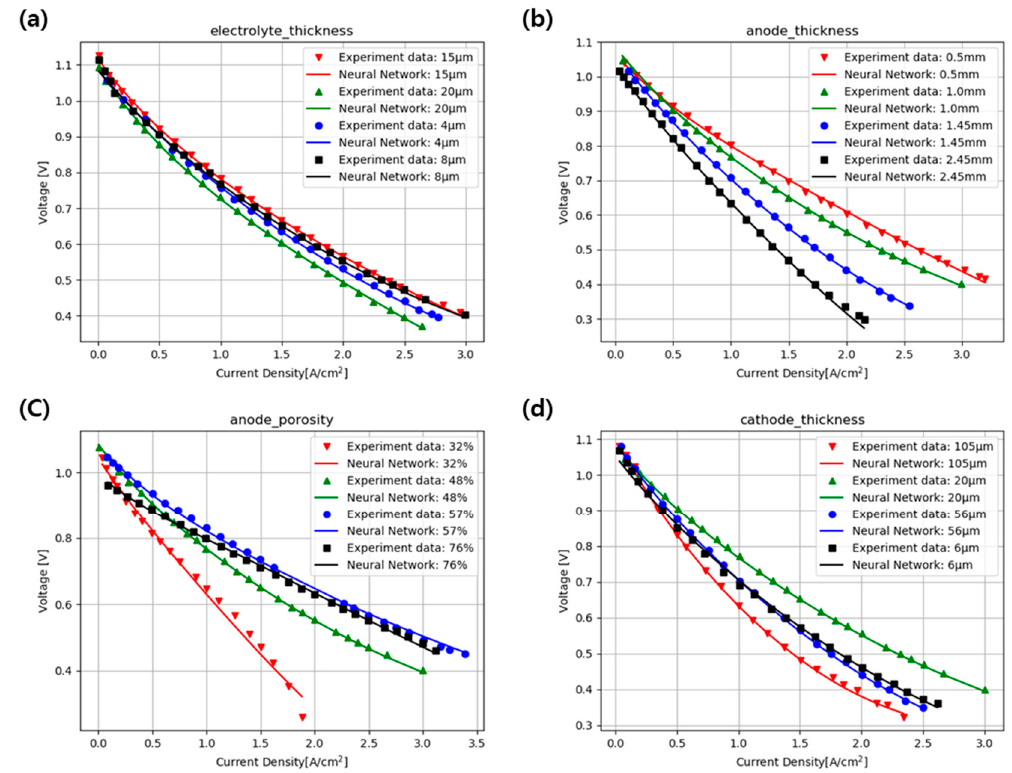
Figure 3. Experimental data points and polarization curves of the SOFC model based on the neural network for: ( a ) Electrolyte thickness, ranging from 4 to 20 µ m, ( b ) anode support thickness, ranging from 0.5 to 2.45 mm, ( c ) anode support porosity, ranging from 32 to 76%, and ( d ) cathode interlayer thickness, ranging from 6 to 105 µ m.